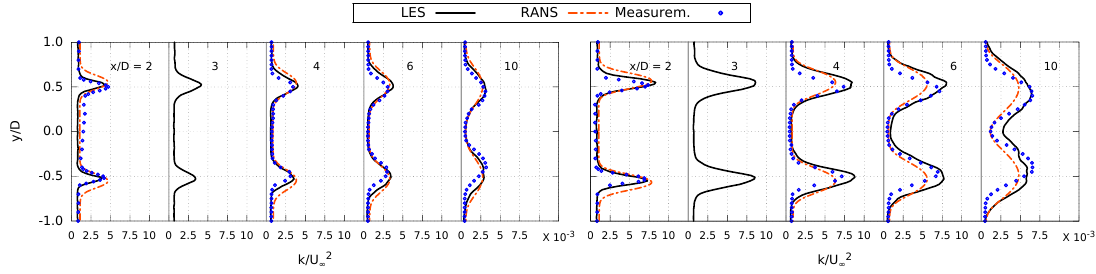
Figure 7. Vertical profiles of k behind the disk C T = 0.42 ( left ) and C T = 0.62 ( right ), Ti3 case.